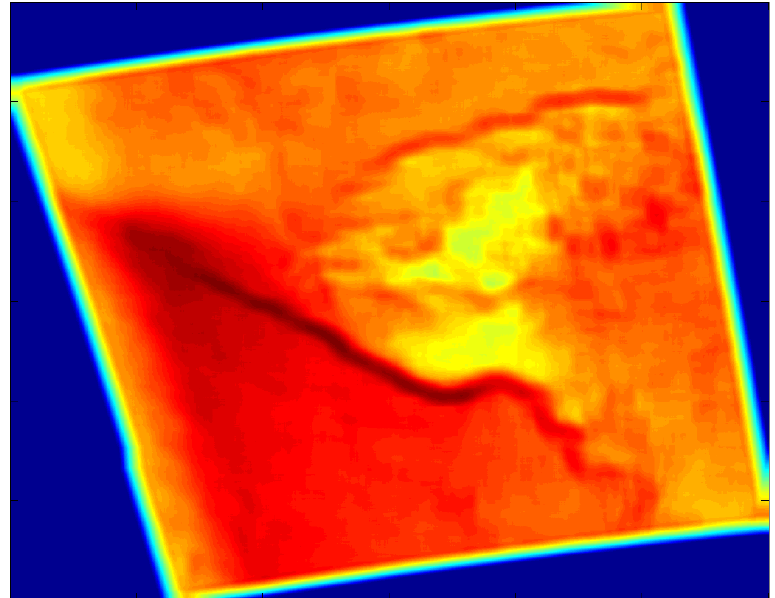
Figure 6. Local entropy filtered SDWS image for the case study, 0533 UTC on December 9, 2007. The two meandering darker red bands indicate the fronts. The seclusion appears as a green area in between.